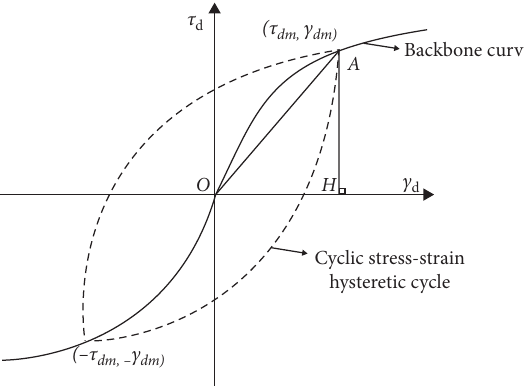
Figure 4: Single cyclic stress–strain hysteretic cycle.